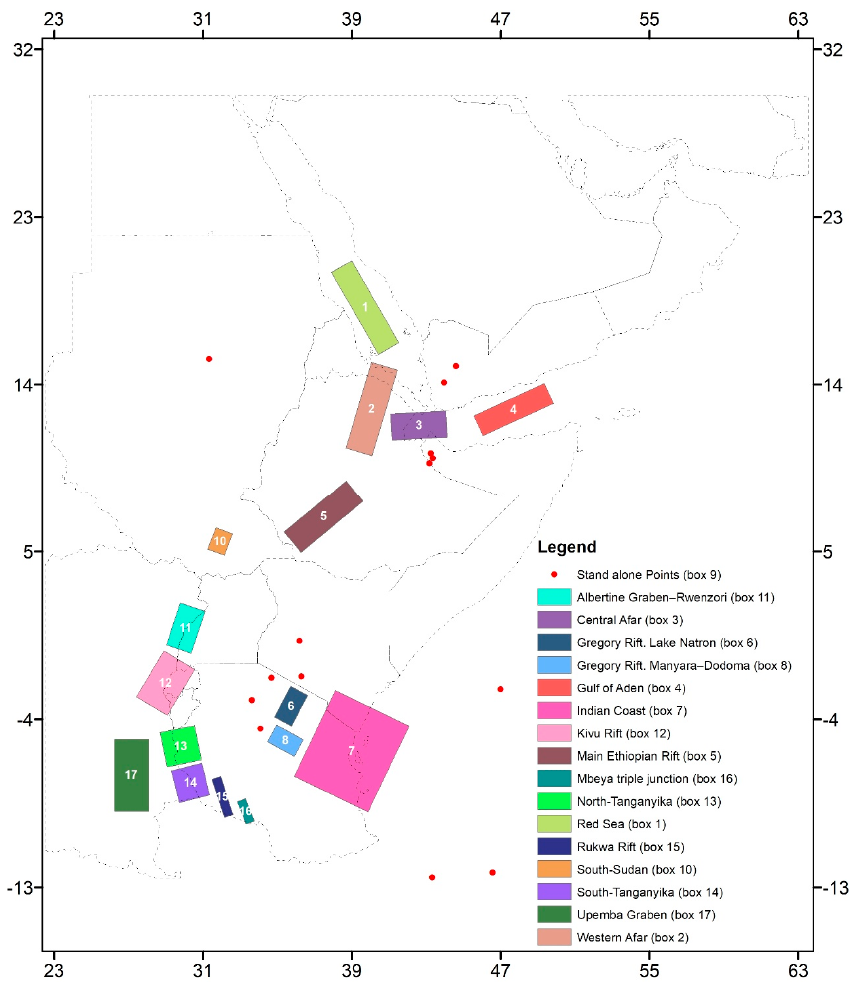
Figure 10. Focal mechanism data assembled into boxes according to